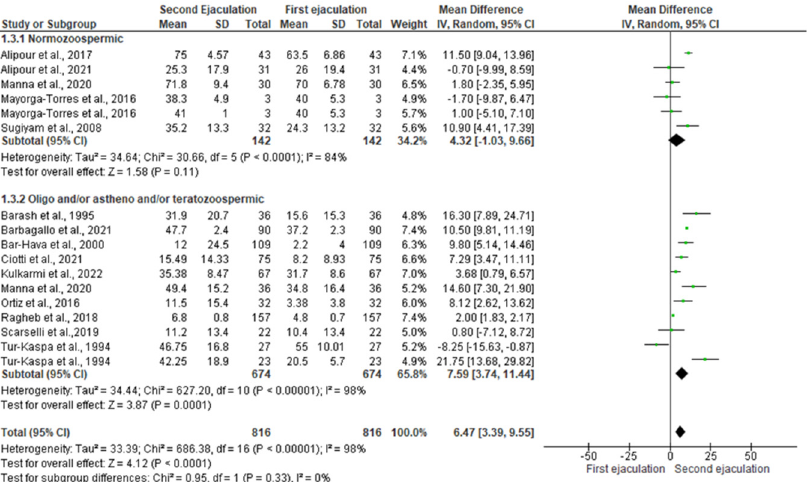
Figure 4. Forest plot of studies that evaluated the effects of a very short abstinence period on total sperm motility (expressed in percentage). The following studies were included in the quantitative analysis (in order of appearance in the manuscript): Manna et al., 2020 [16], Ortiz et al., 2016 [18], Alipour et al., 2017 [19], Ragheb et al., 2018 [20], Ciotti et al., 2021 [22], Tur-Kaspa et al., 1994 [27], Barash et al., 1995 [28], Bar-Hava et al., 2000 [29], Sugyam et al., 2008 [30], Mayorga-Torres et al., 2016 [32], Scarselli et al., 2019 [33], Alipour et al., 2021 [34], Barbagallo et al., 2021 [35], and Kulkarmi et al., 2022 [36].